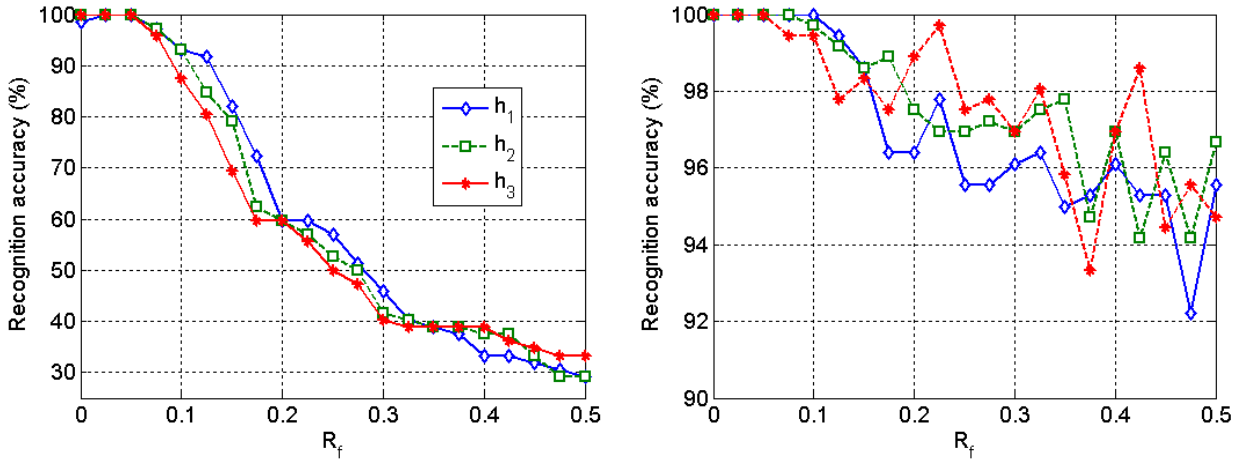
Figure 27. Classification accuracies on test set of eye image data, where h perturbation factors in the computational hardware model